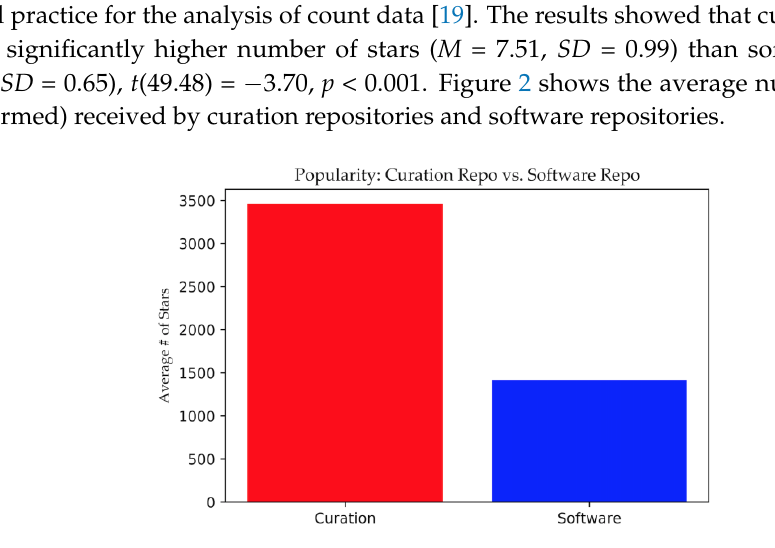
Figure 2. Average number of stars received by curation repositories and software repositories.